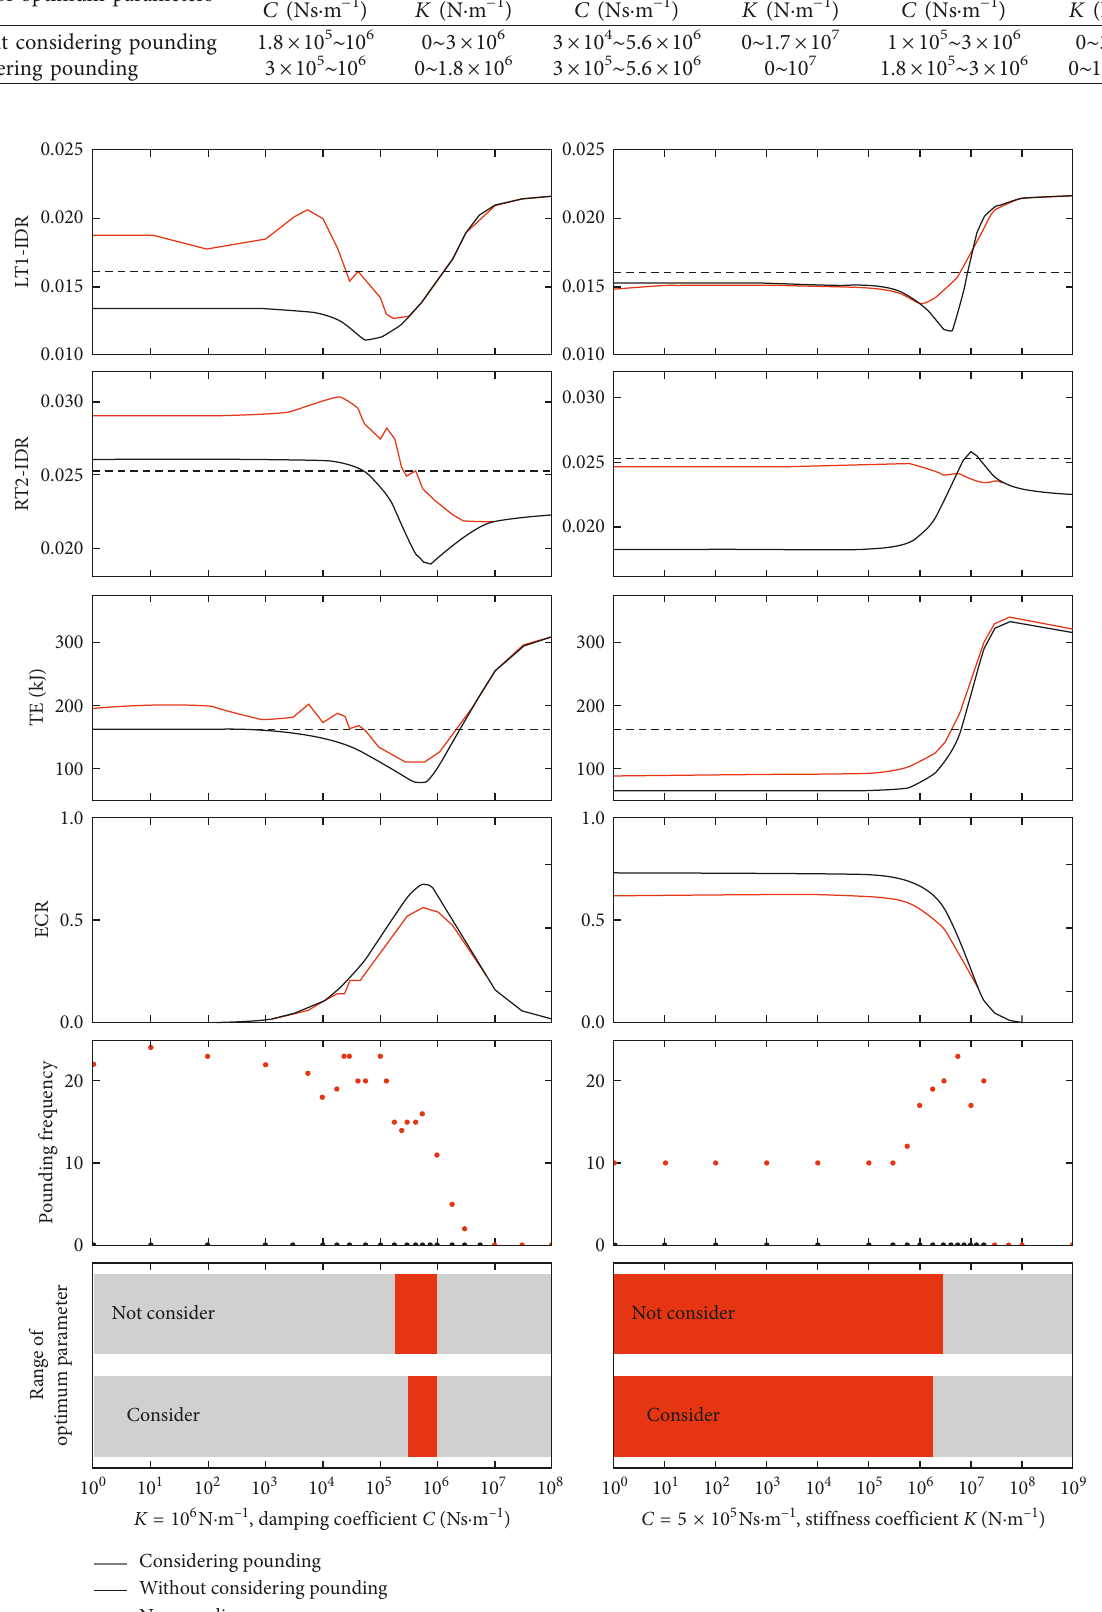
Figure 4: Comparison between the structures considering pounding and without considering pounding (GM11).